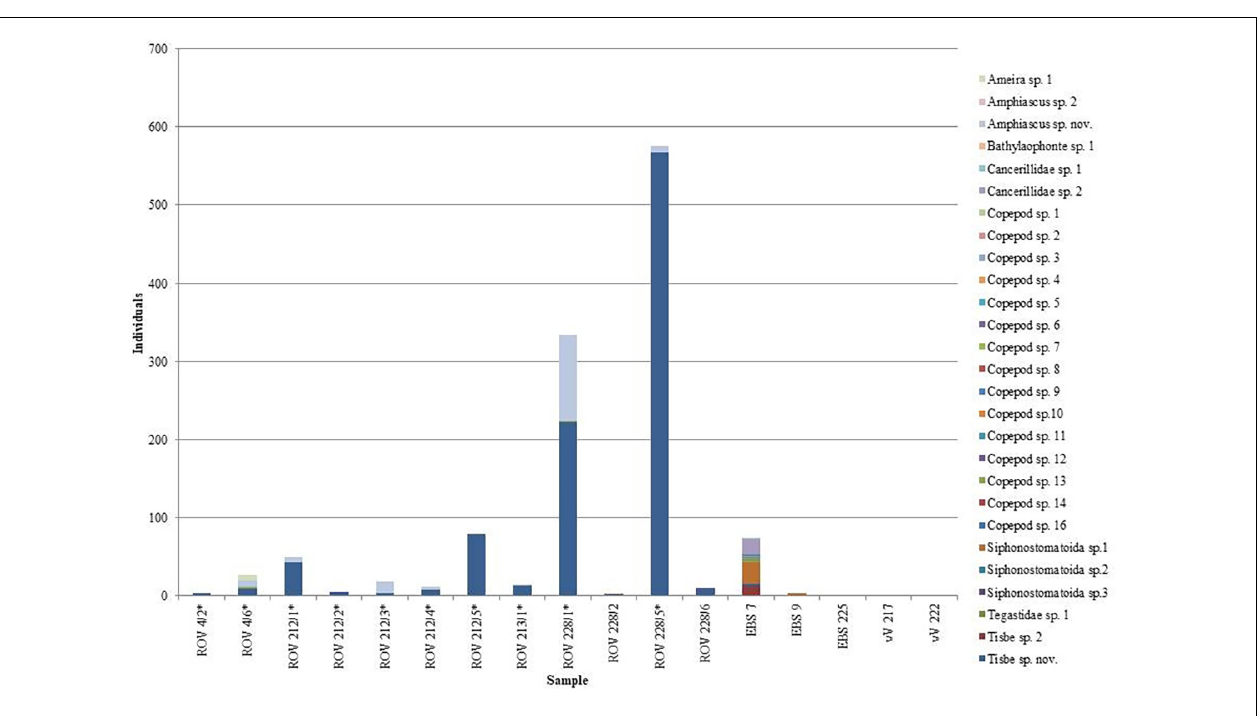
Polychaeta. A total of 4328 specimens of polychaetes representing 40 families were recorded in the samples from the Steinahóll area ( Supplementary Table 3 ). About 60% of the specimens were collected by use of EBS, 25% by ROV and 15% by van Veen. The ROV samples taken from hydrothermal influenced sediments (9 samples) contained 1284 specimens representing 20 families of polychaetes, of which two, Dorvilleidae (530 specimens) and Capitellidae (466 specimens), accounted for more than 75% of